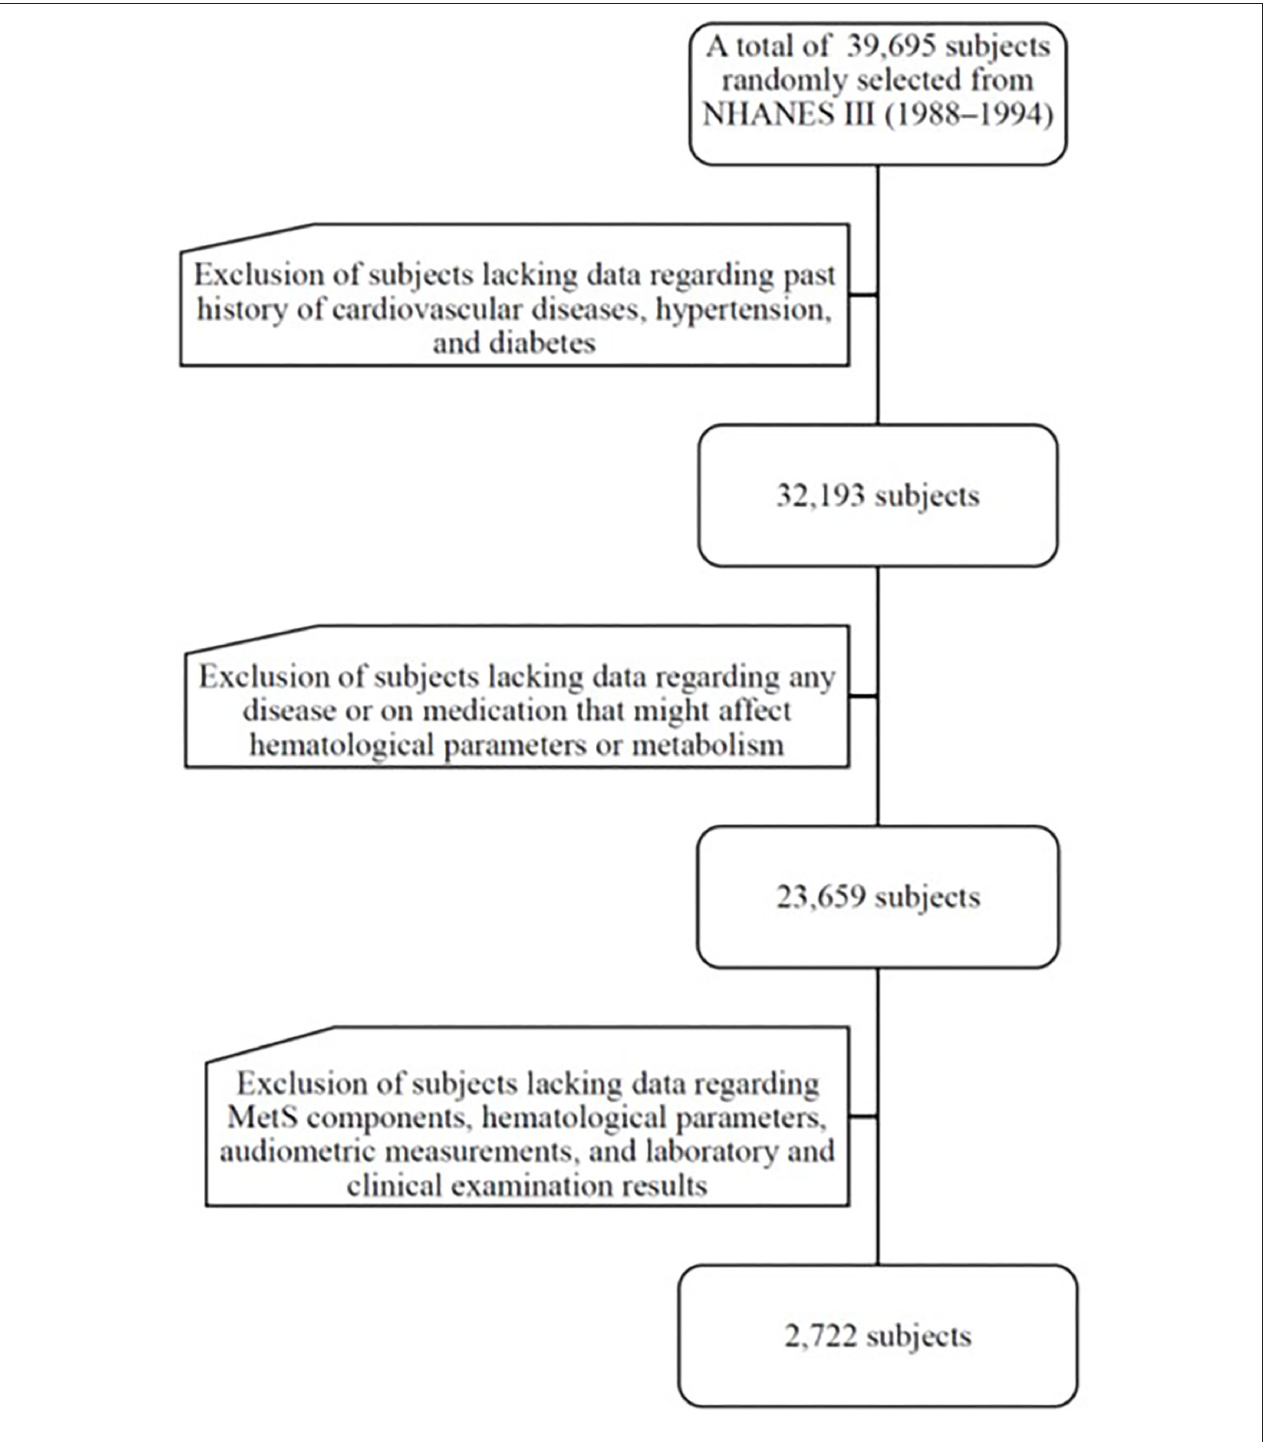
FIGURE 1 | Flow diagram of the selection of participants.